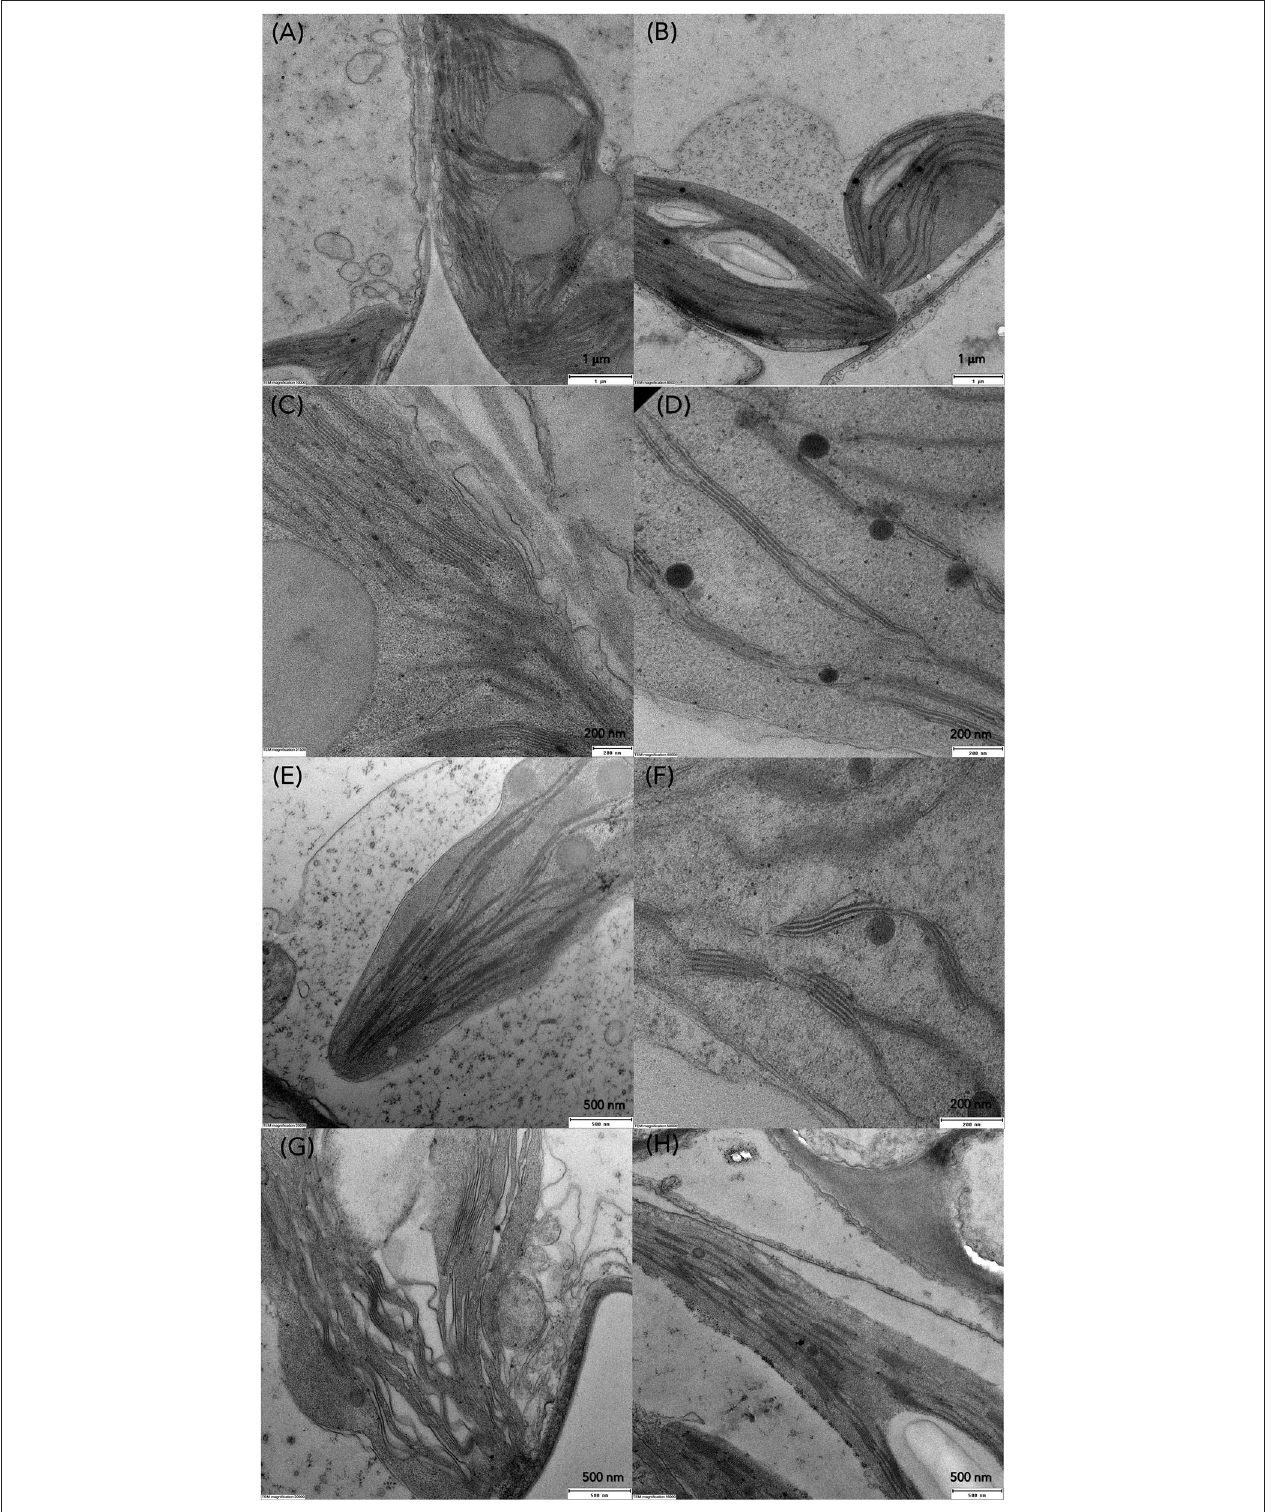
FIGURE 8 | TEM micrographs of chloroplasts in control (A,C) MFs, (B,D) GDFs, and changes in thylakoid organization in S. polyrhiza chloroplasts of MFs and GDFs exposed to (E,F) C1 and (G,H) C3Cd concentration after 24h.